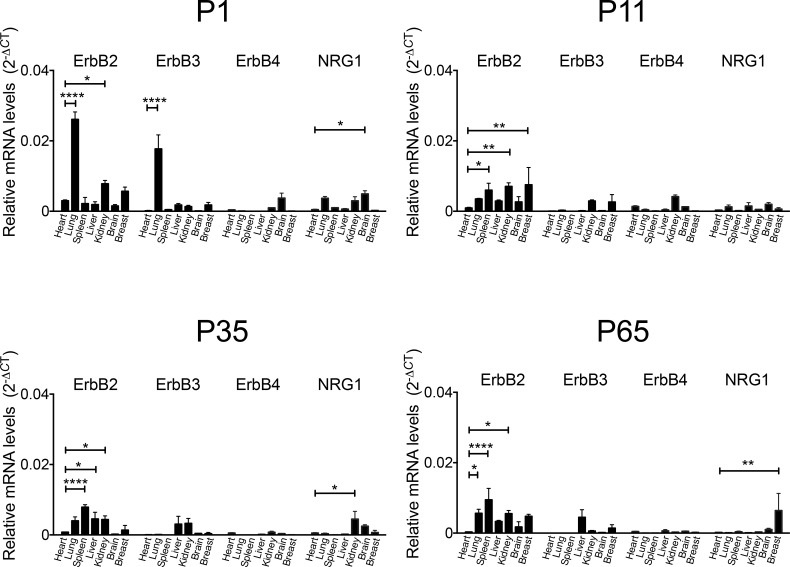
ErbB receptors are broadly expressed.Mice were euthanized on day of life 1, 11, 35, and 65. Real time PCR showed all examined organs expressed ErbB receptor subunits. Statistical significance was tested in comparison to heart samples for each time point by analysis of variance (ANOVA) followed by Bonferroni’s multiple comparison test. *P<0.05, **P<0.01, ***P<0.001, ****P<0.0001.